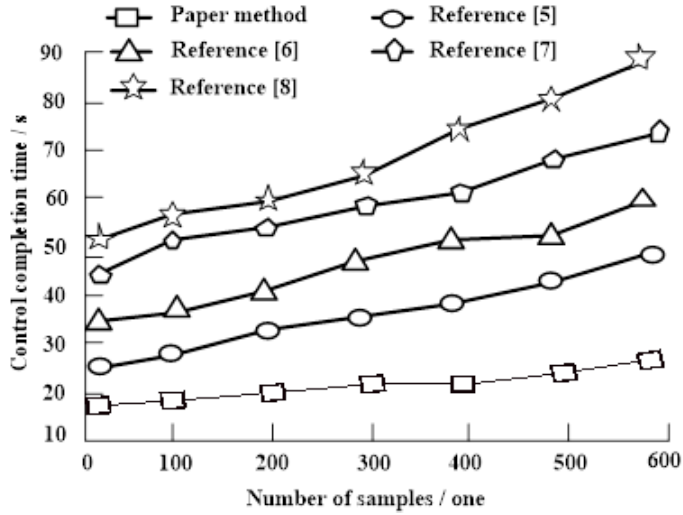
Figure 2. Comparison of node density control completion time.